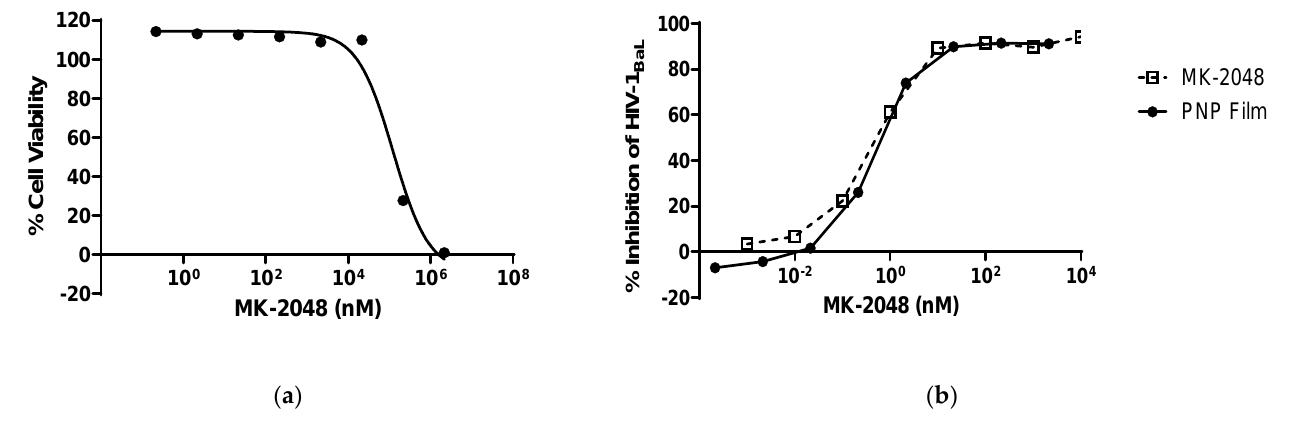
Figure 3. PNP film efficacy study using the TZM-bl antiviral assay. ( a ) CT 50 of the MK-2048 PNP Film Cell Viability Assay. ( b ) MK-2048 PNP Film HIV-1 Inhibition Assay IC 50 . CT 50 : concentration required to kill 50% of the exposed cells; IC 50 : concentration required to achieve 50% inhibition of HIV.